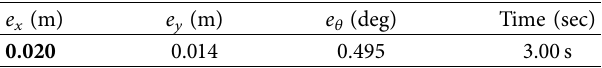
Table 13: The mean of the estimation errors of the PF (two landmarks and Gaussian